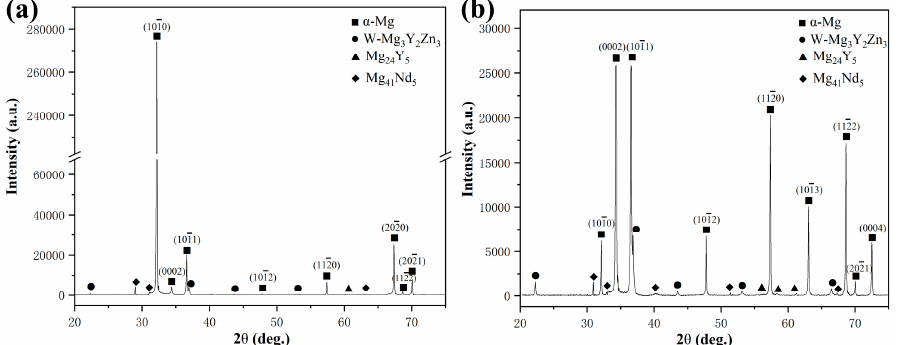
Figure 5. XRD patterns of the Mg–Zn–Y–Nd alloy with one-pass hot extrusion: ( a ) cross section of the extrude alloy (perpendicular to the extrusion direction), ( b ) longitudinal section of the extruded alloy (parallel to the extrusion direction).